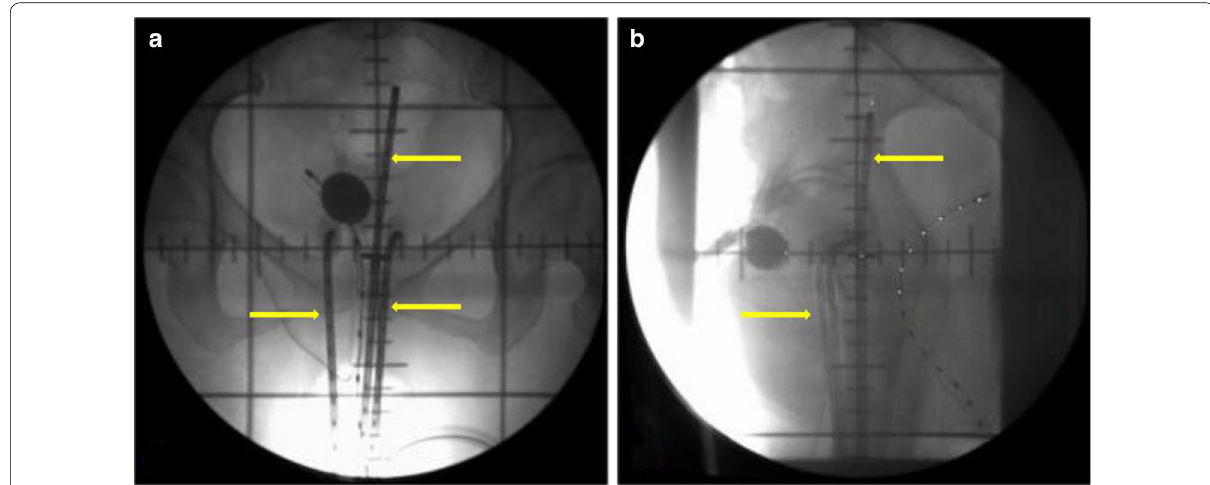
Fig. 1 Schematic representation of californium‑252 ( 252 Cf) neutron brachytherapy (NBT). Contrast media was injected into a Foley catheter. Then, three passive cavity applicators were inserted into the uterine cavity and bilateral fornix; the applicator that delivers 252 Cf was inserted and fixed to the vagina and uterine cavity. Finally, orthogonal radiographs of the pelvic cavity were acquired from the antero‑posterior ( a ) and lateral ( b ) direc‑ tions. The yellow arrows indicate the cavity